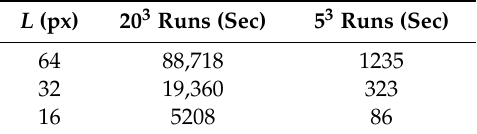
Table 1. CPU time required to perform Monte Carlo simulations.